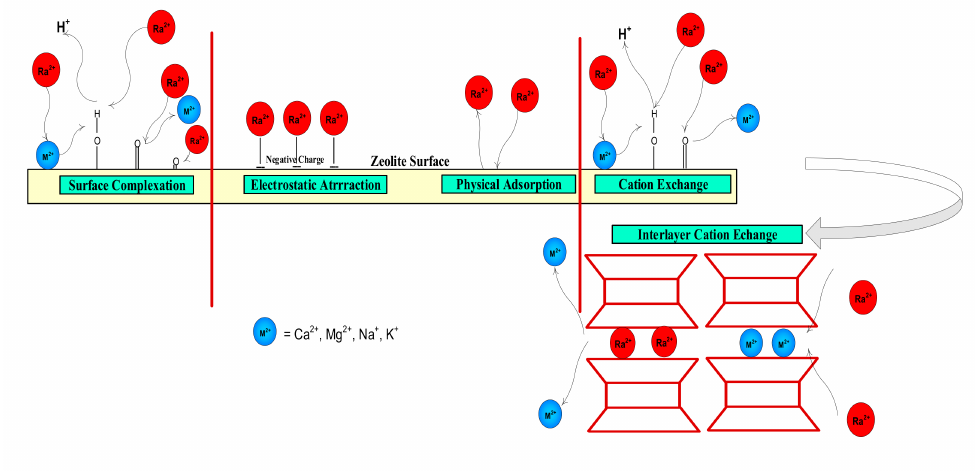
Figure 6. The FT-IR spectrum comparing between the raw zeolite and after 226 Ra adsorption onto zeolite.